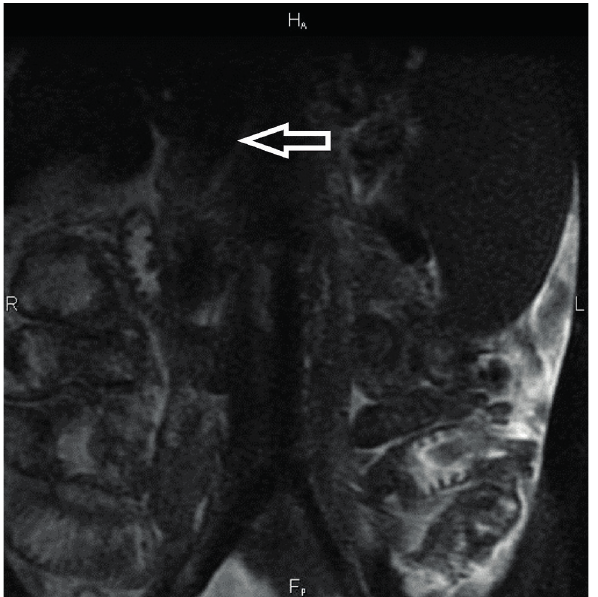
Fig. 3. MRCP + MR enterography with maghemite contrast agent (same patient as in Fig. 2): in cirrhotic liver transforma- tion. Visible improvement of extrahepatic biliary ducts delinea- tion after SPIO per-oral application.